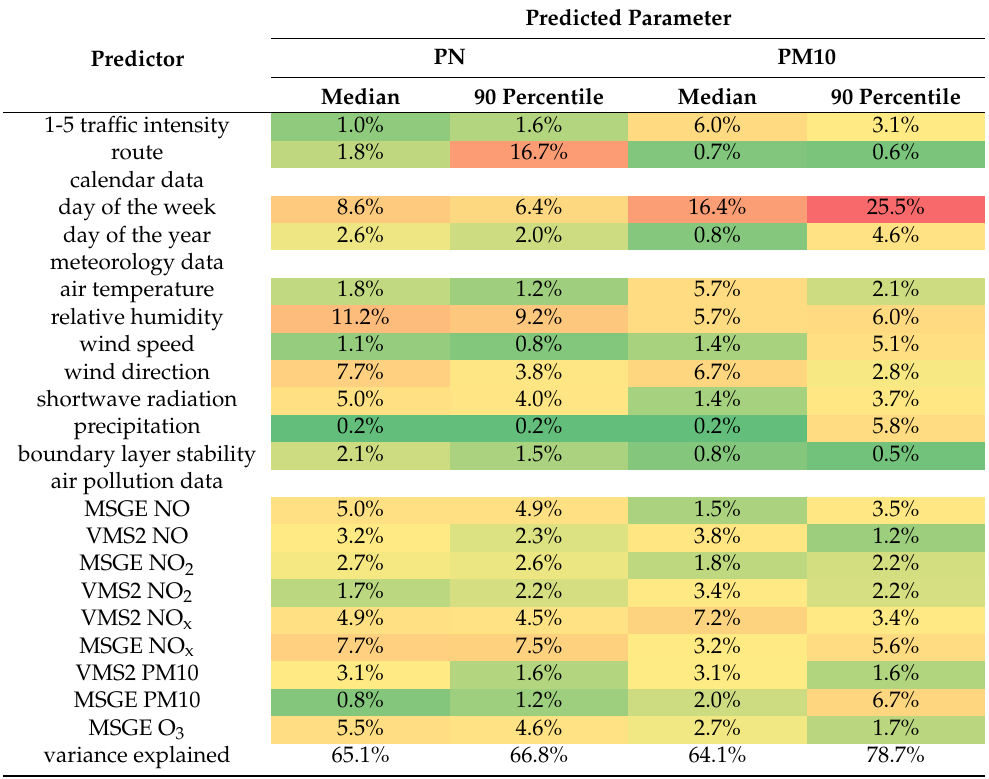
Table 1. Contributions of predictors to medians and 90th percentiles of PN and PM10 concentrations of all 80 single laps (high-traffic routes and low-traffic routes during 40 rides). The coloring of cells is for clarification purposes